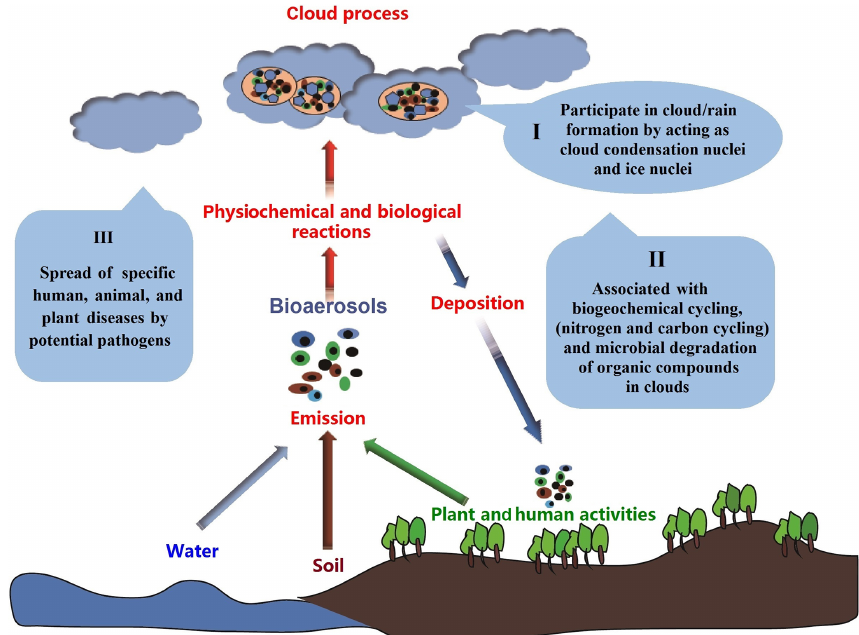
Figure 3. Schematic representation of bioaerosols’ life cycle and potential influence on atmosphere, ecosystem, and human health, modified from Pöschl (2006). In clouds, the bacterial potential functions are indicated in the figure. Bioaerosols are emitted from various terrestrial environments, e.g., soil, water, plants, animals, or human beings, which may include pathogenic or functional species. These bacteria can be attached to particles or incorporated into water droplets of clouds/fog. Certain species can serve as biogenic nuclei for cloud condensation nuclei (CCN) and ice nuclei (IN), which induce rain formation, precipitation, and wet deposition of gases and particles. For the potential pathogens and functional bacteria, during cloud processes, they can be deposited back to land via deposition and possibly induce human infections and affect the diversity and function of aquatic and terrestrial